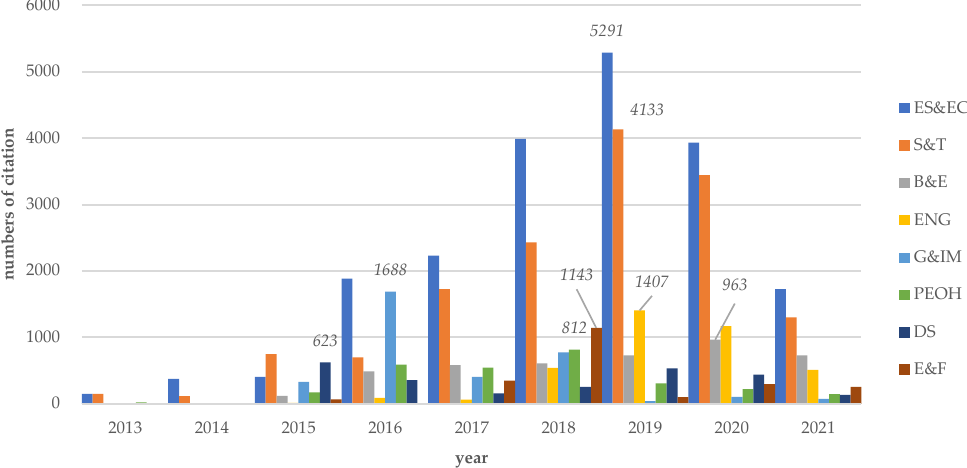
Figure 2. The number and trends of citations in the top eight fields and the number in the top year for each field.